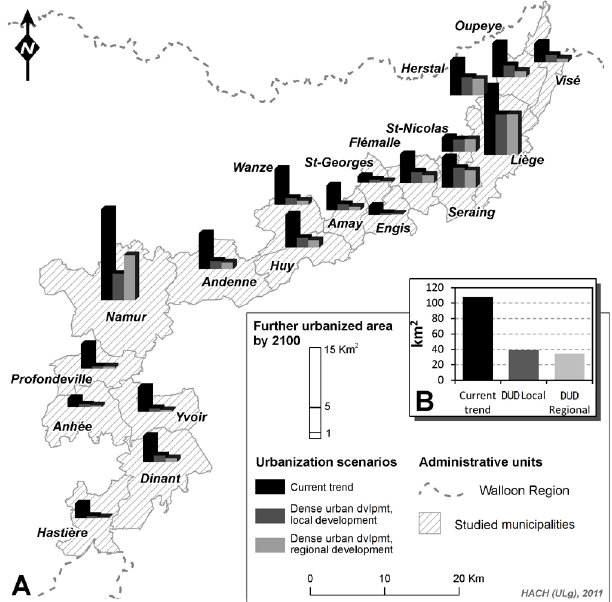
Fig. 13. New residential areas in Namur, year 2100. (A) Current trend scenario; (B) dense urban development, regional development scenario; and (C) dense urban development, local development scenario. A high level of restriction on development in flood-prone areas was considered here.